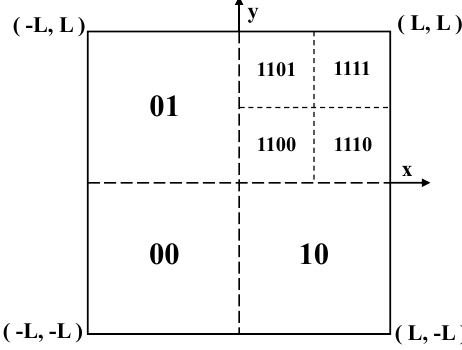
Figure 4. Encoding schema of TQ-tree